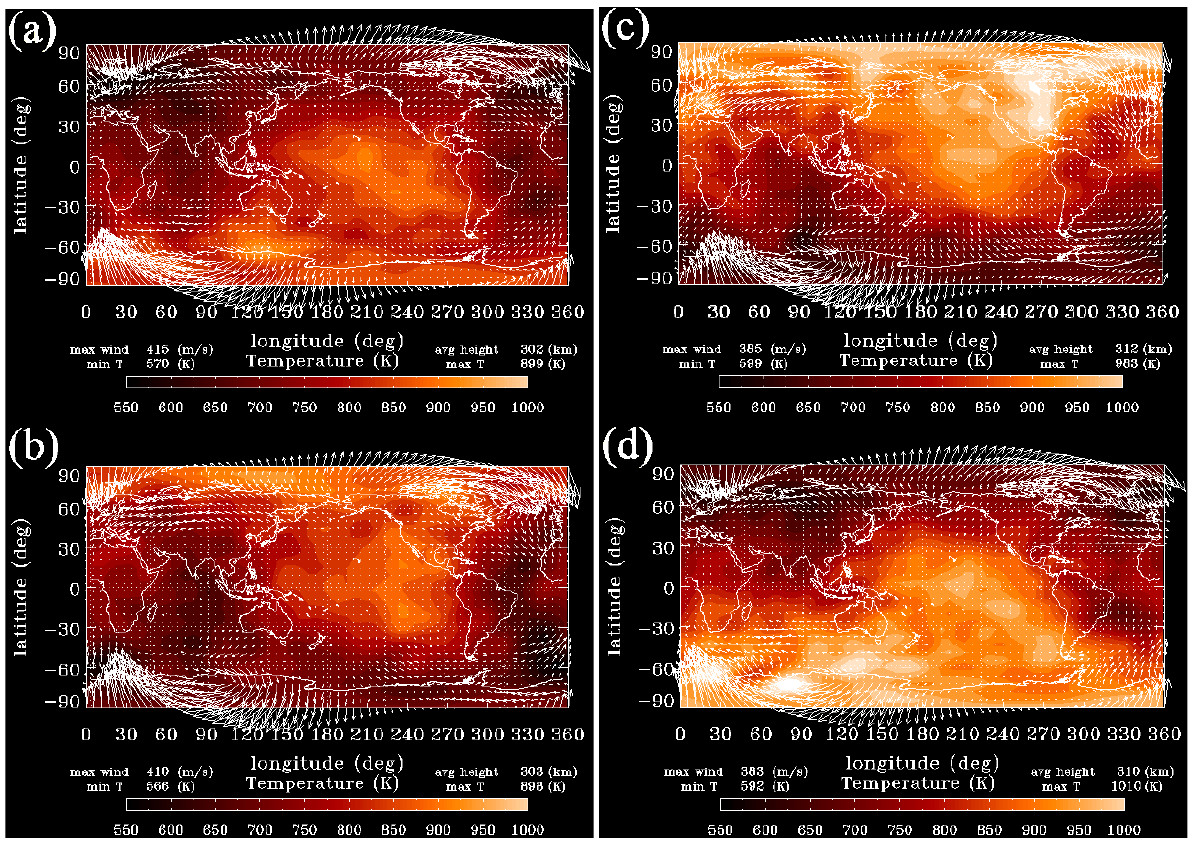
Fig. 1. The global distributions of temperature and horizontal wind on a constant-pressure surface ( ∼ 302–312km altitude) at 01:00UT in (a) 1 March, (b) 1 September, (c) 1 June, and (d) 1 December. Note that the strength of the maximum wind vector is different in each panel.